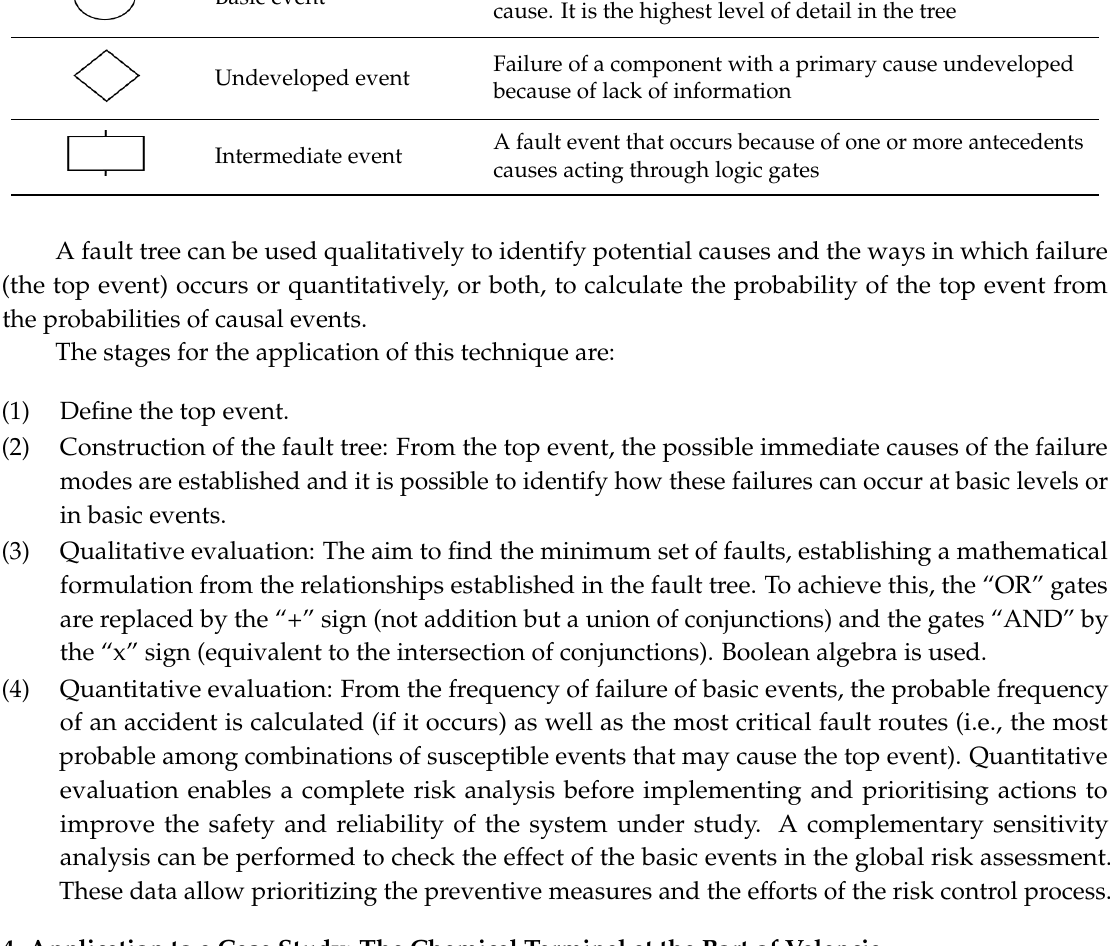
Table 2. Symbols used in fault trees. Source: ISO 31.010:2011 [27] and Vesely et al. [37].